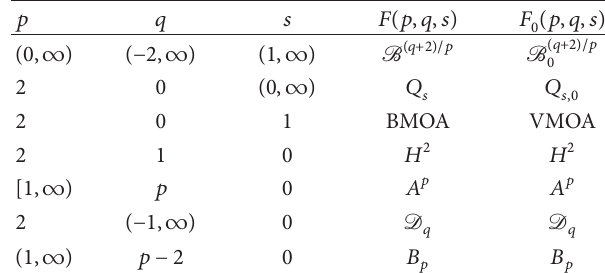
Table 1: General function family 𝐹(𝑝,𝑞,𝑠) and the classical function